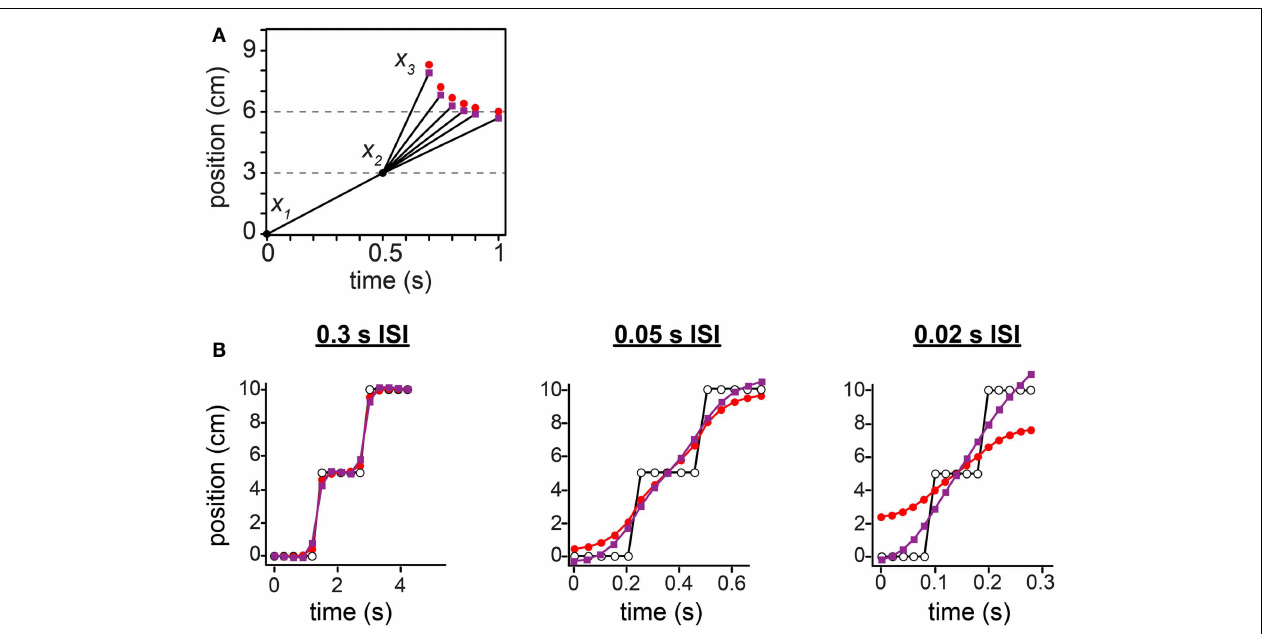
performance. (B) The 15-tap rabbit. Red points: low-speed-prior observer’s performance, reproduced from Figure 11B . Purple points: low-acceleration- prior observer’s performance. For both observers in (A) and (B) , τ was set to 0.10s (i.e., σ s = 1cm, σ v = 10cm/s).